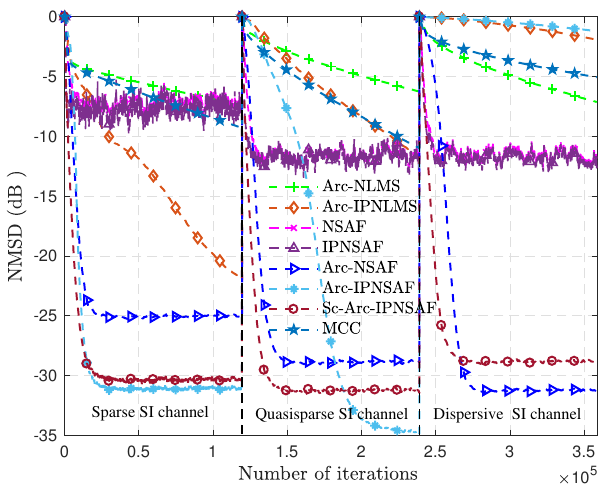
Figure 7. NMSD of different algorithms in sparse, quasisparse, and dispersive SI channels, and the input signal is the AR(2)